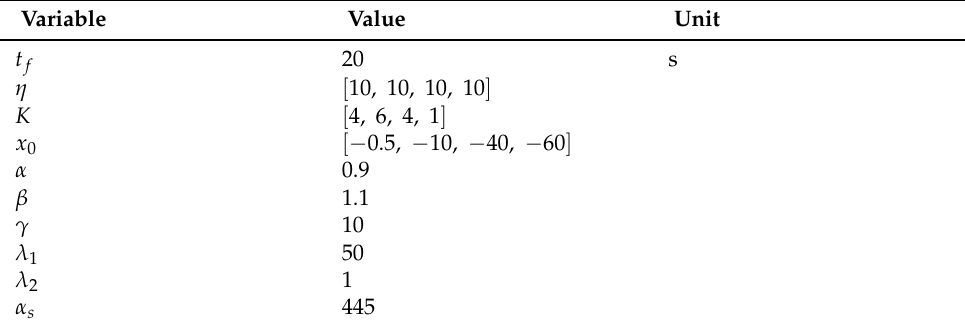
Table 2. PMSM parameter values.